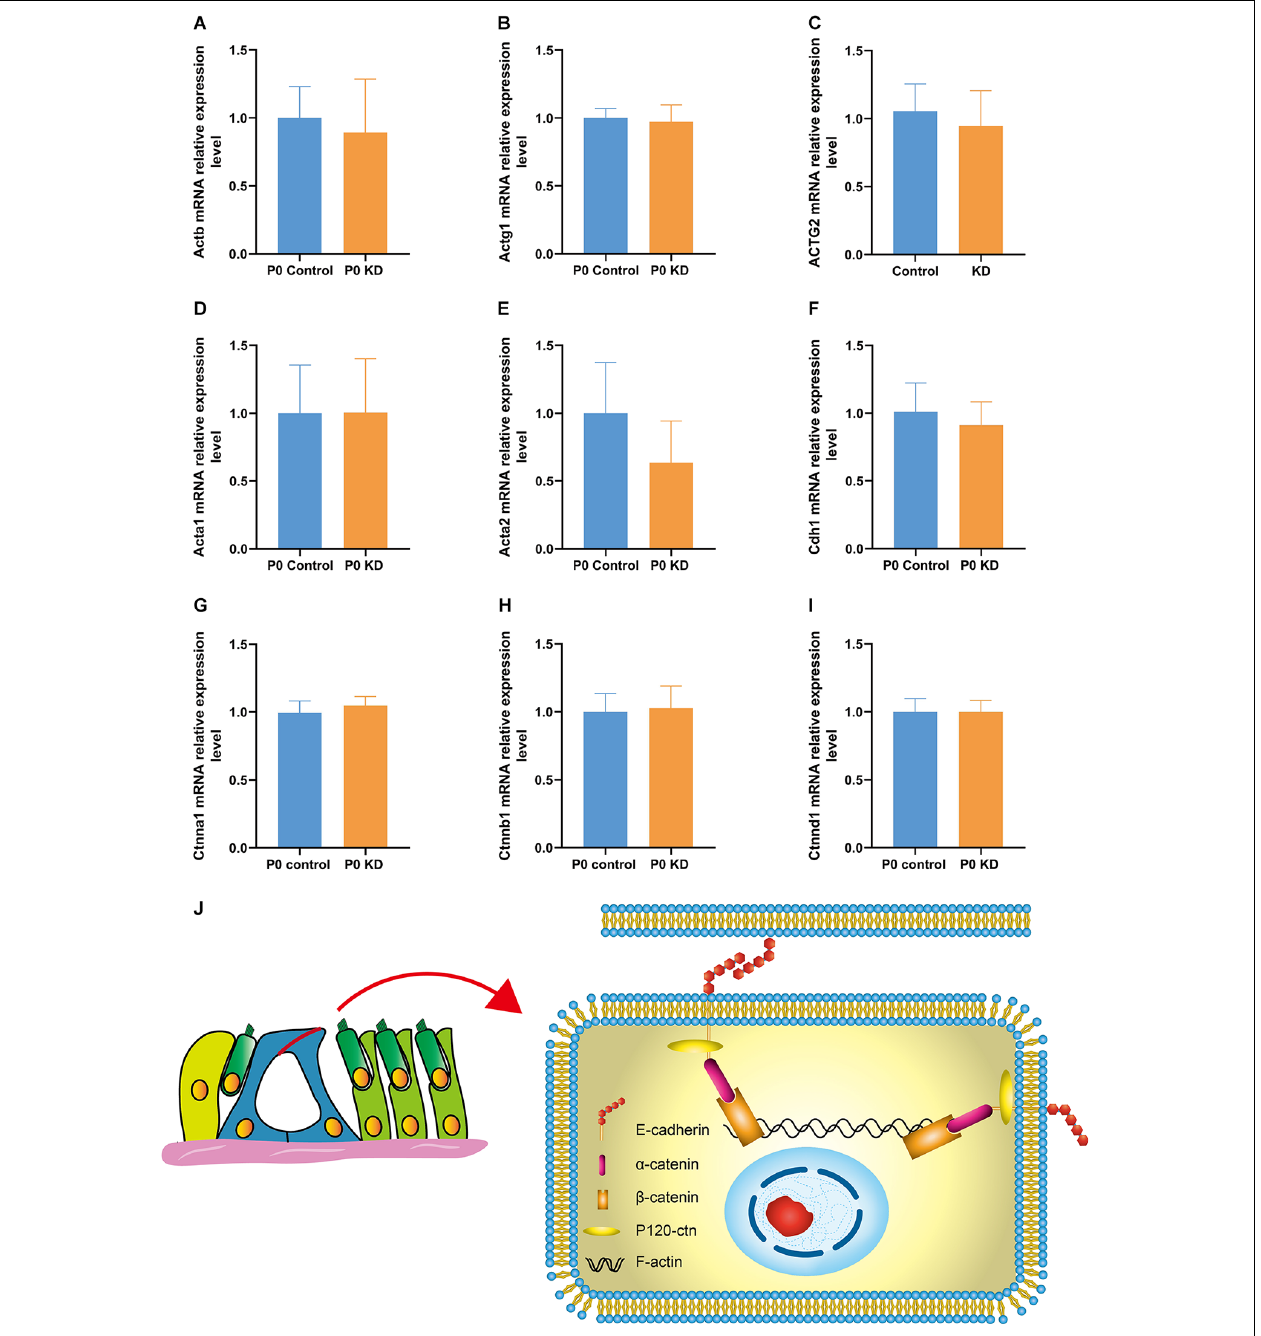
FIGURE 4 | mRNA expression relative expression level of G-actin and the cadherin–catenin core complex in P0 KD group. mRNA expression level in P0 control and P0 KD groups (A–I) . The differences between the P0 KD group and the P0 control group were not significant ( P > 0.05). Adhesive protein complexes at adherens junctions between IPCs and OPCs (J)